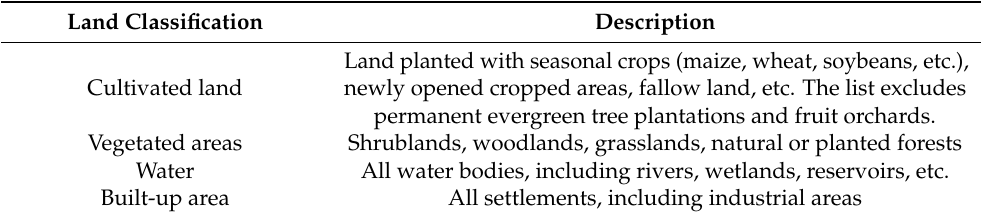
Table 1. Land-cover classification types used as training samples to classify irrigated areas.